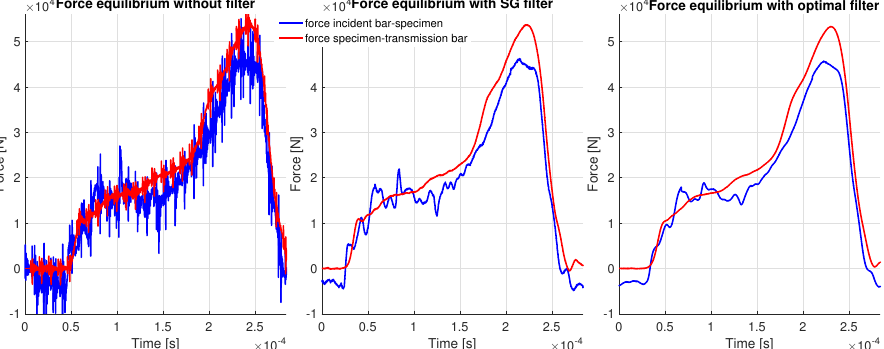
Figure 9. Comparison of force equilibrium obtained without signal filtering and with two different filters: l (long striker), v s = 45 . 36 ms − 1 (high striker